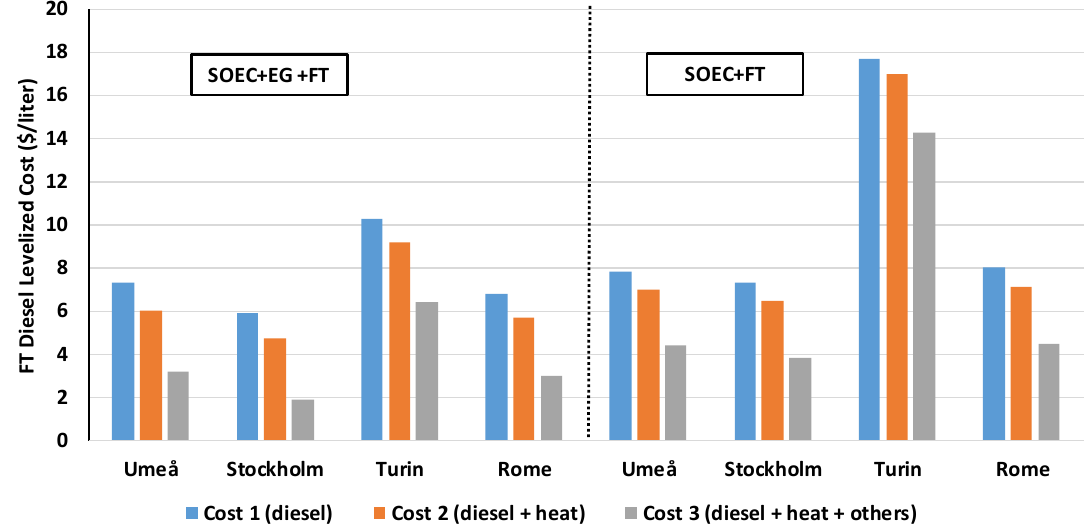
Figure 7. FT diesel production cost ($/L).